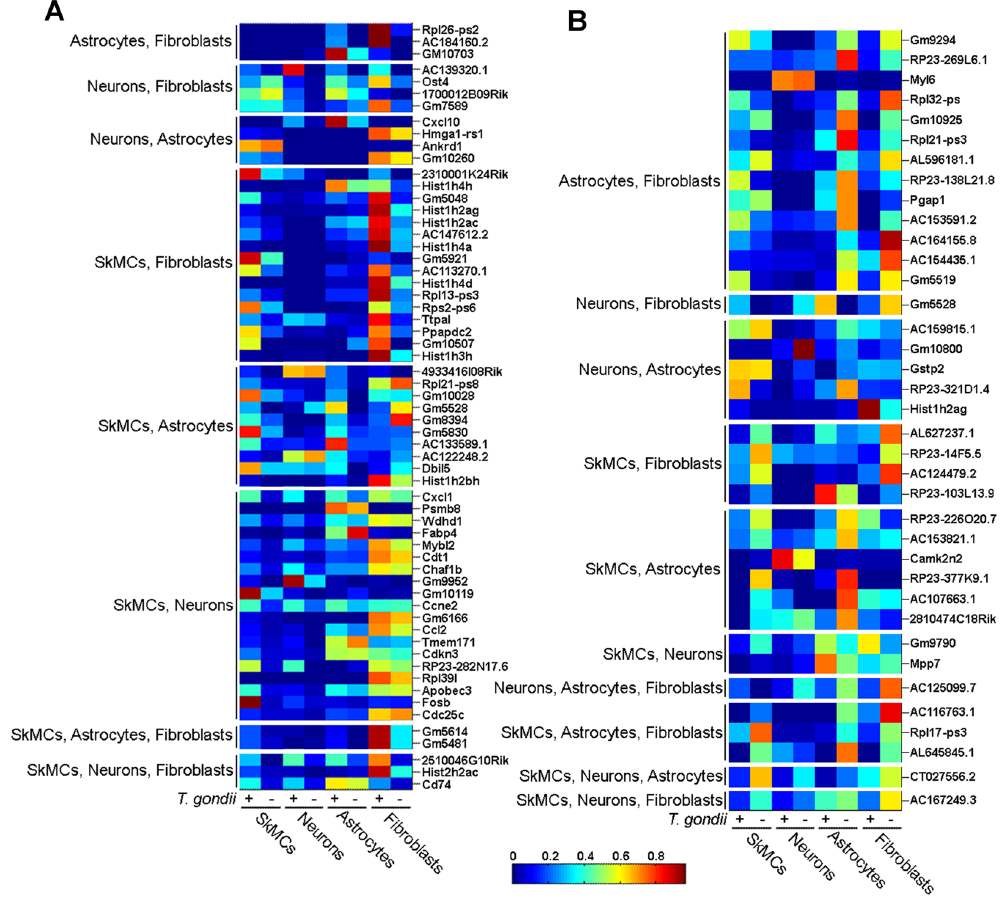
Figure 2. Common transcriptional responses of SkMCs, neurons, astrocytes and fibroblasts after infection with T. gondii as revealed by RNA high-throughput sequencing. Genes that were commonly regulated in at least two cell types after infection with T. gondii ( > 2-fold; p < 0.05) were clustered according to host cell groups, and expression intensities were visualized using heat maps. ( A ) Genes commonly up-regulated in multiple cell types after infection. ( B ) Genes commonly down-regulated in multiple cell types after